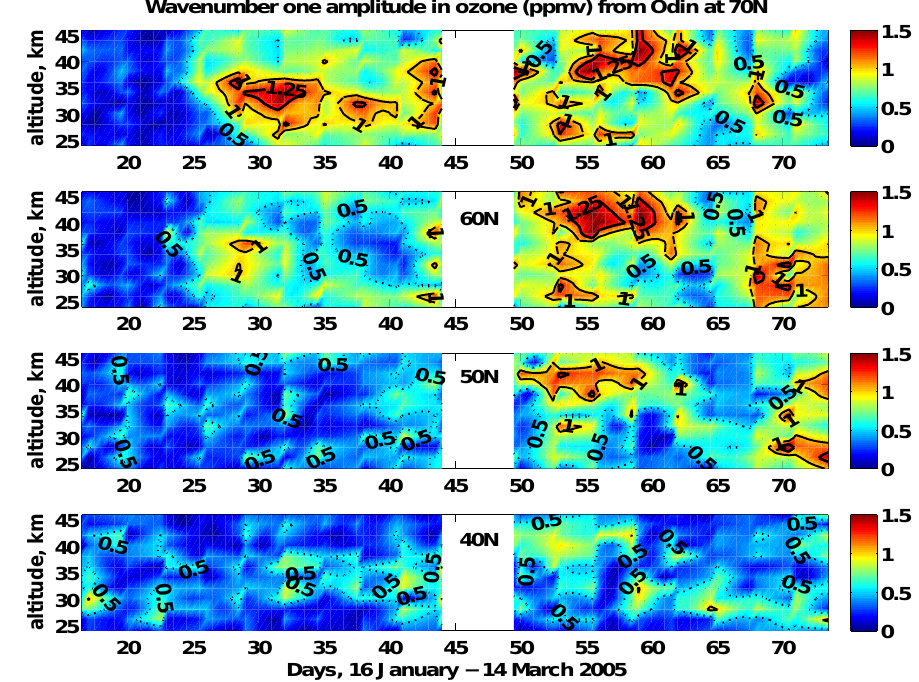
Fig. 12. Wavenumber one amplitude in ozone (ppmv) from Odin SMR data at 70 ◦ N, 60 ◦ N, 50 ◦ N and 40 ◦ N.